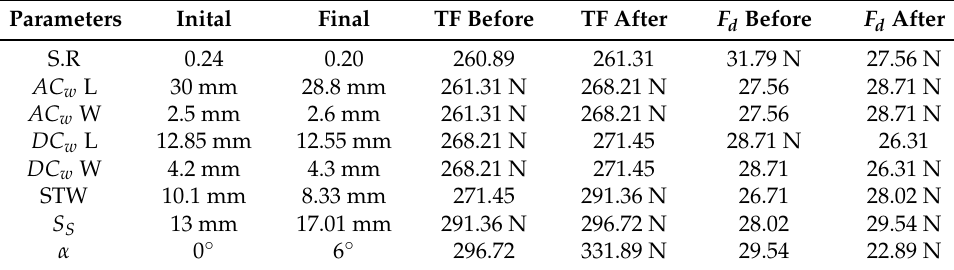
Table 6. Detail of overall optimization.